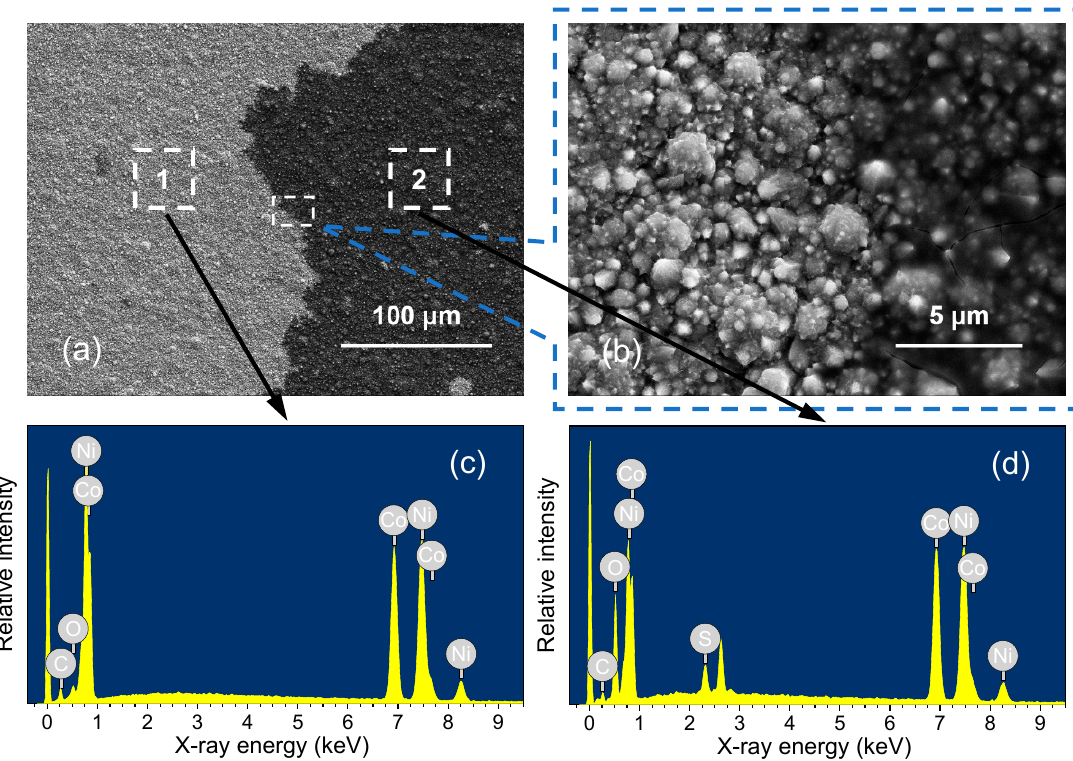
Figure 8. The SEM surface morphology at low ( a ) and high ( b ) magnification and EDS spectra of area 1 ( c ) and area 2 ( d ) with different morphologies of Ni–Co/SS304 after polarization (0.6 V, 5 h) in the simulated PEMFC cathodic environment.